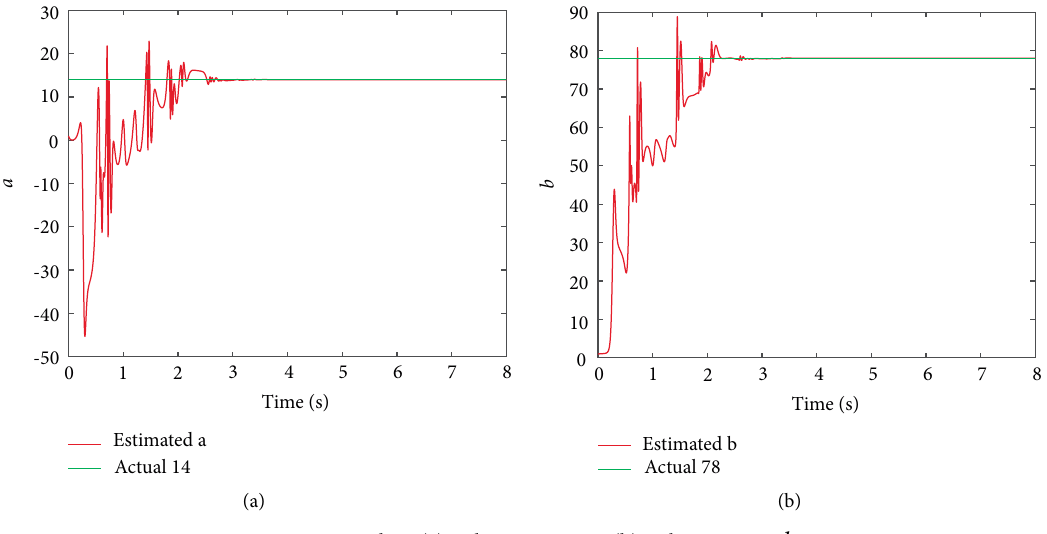
Figure 6: Switch-1: (a) unknown term 𝑎 , (b) unknown term 𝑏